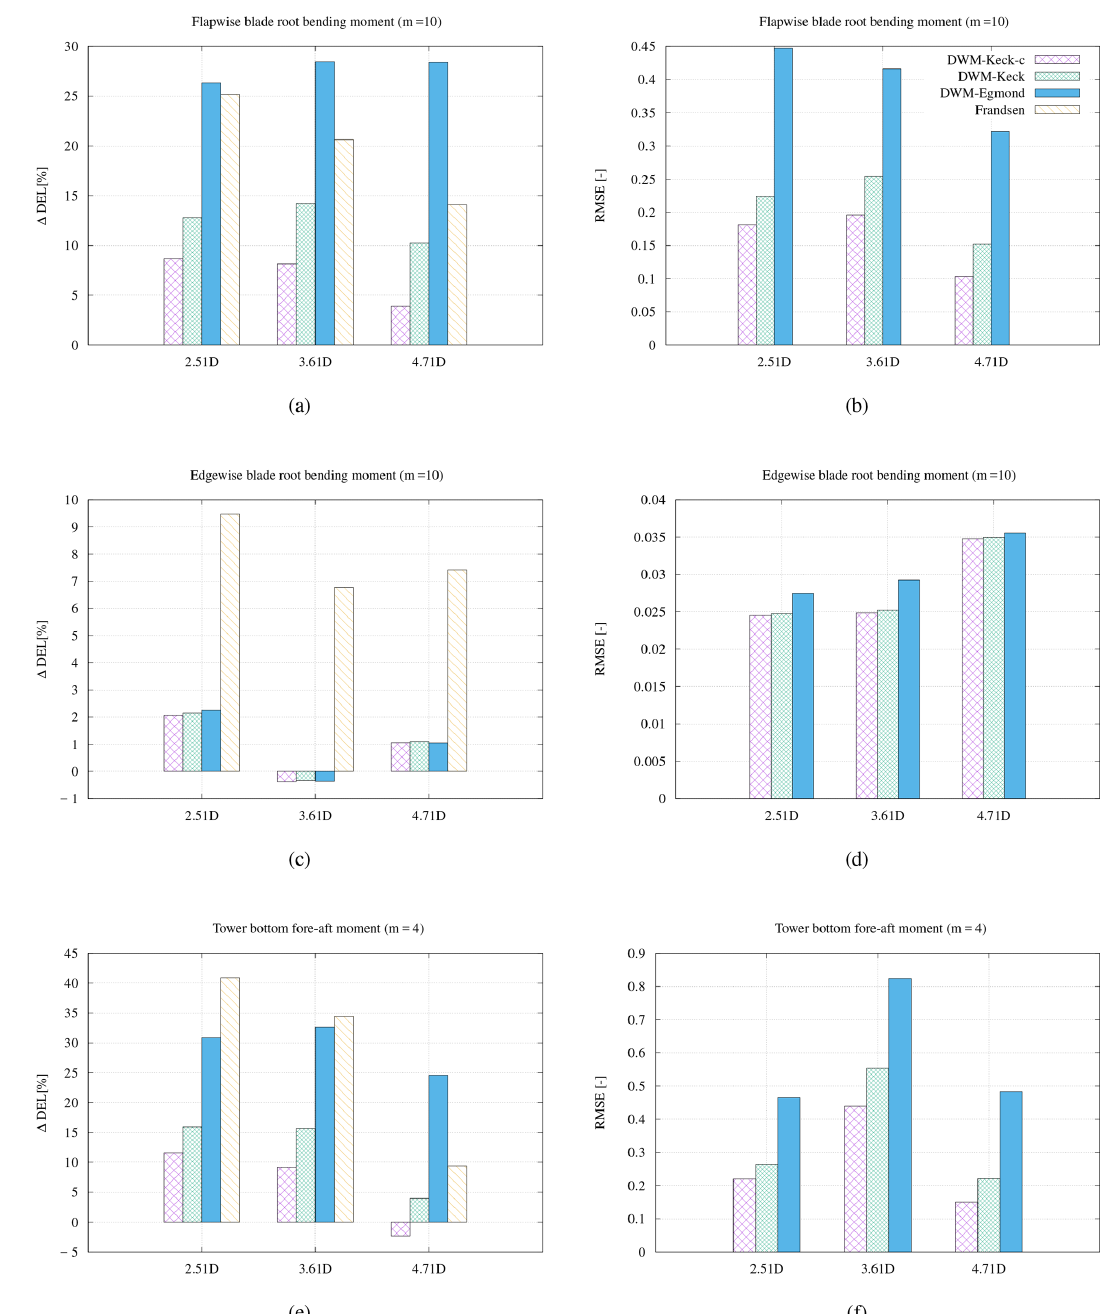
Figure 13. Bias between the measured and simulated fatigue loads and the root-mean-square error for the flapwise blade root bending moment (a, b) , the edgewise blade root bending moment (c, d) , as well as the tower bottom bending moment (e, f) at an ambient wind speed of 8ms − 1 and an ambient turbulence intensity of